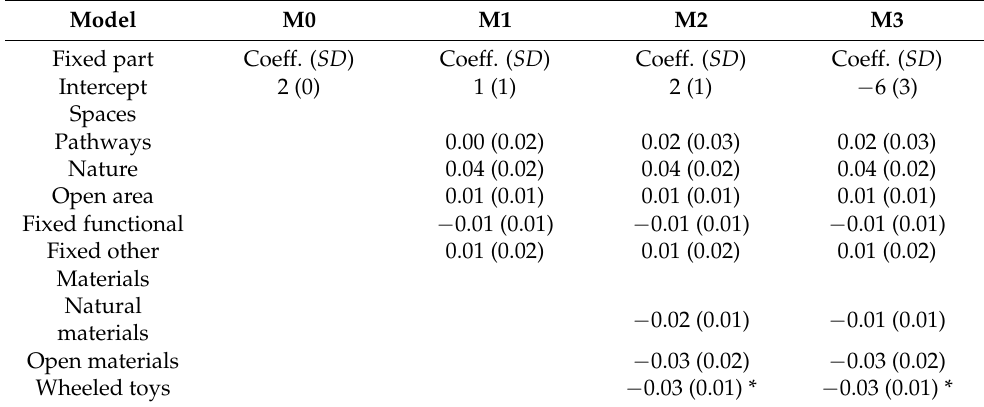
Table 5. Regression models for rough-and-tumble play ( n = 935